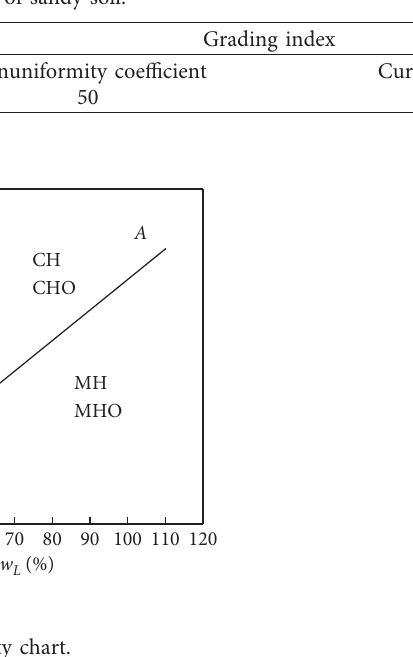
Table 1: Grading index of sandy soil.